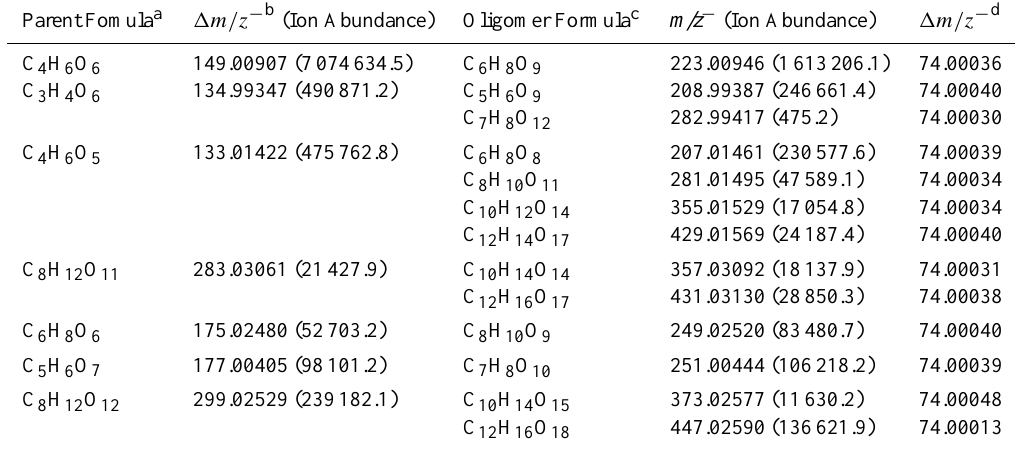
Table 1. A series of oligomeric products increasing by m/z − 74 formed from the radical-reaction of H-atom abstracted parent radical products with the dehydrated glyoxal radical ( R ∗0 1 ). Parent Fomula a 1m/z − b (Ion Abundance)